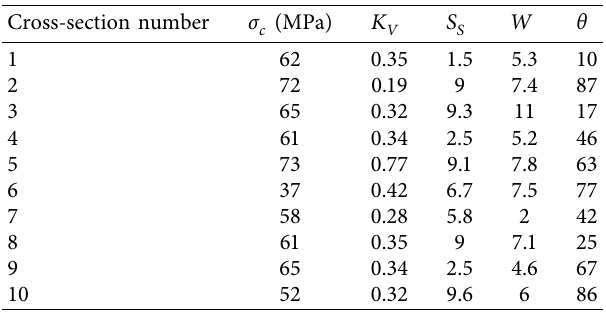
Table 2: The monitoring value.